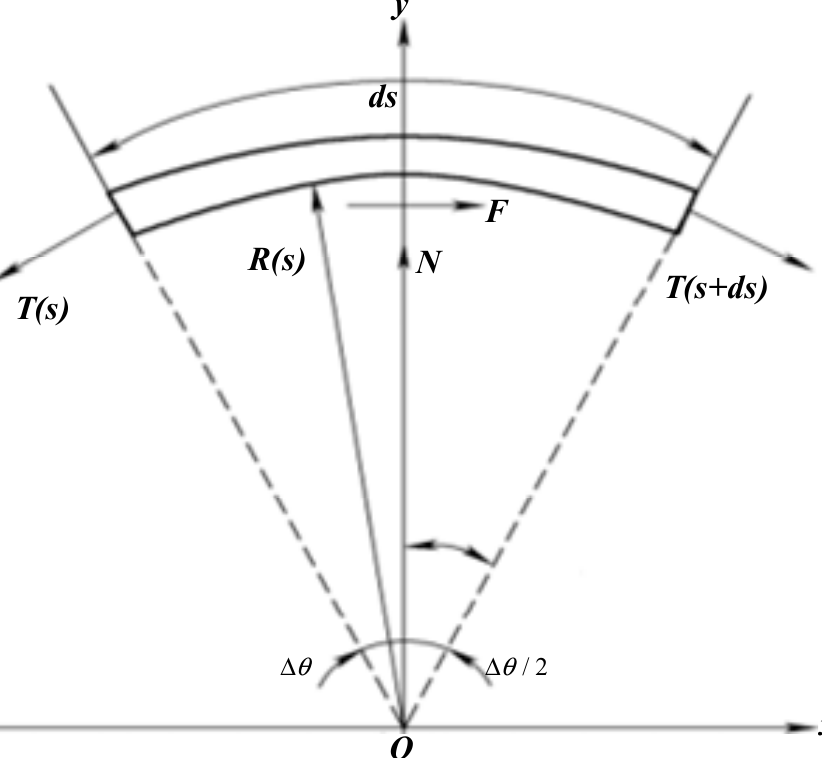
of microelements.